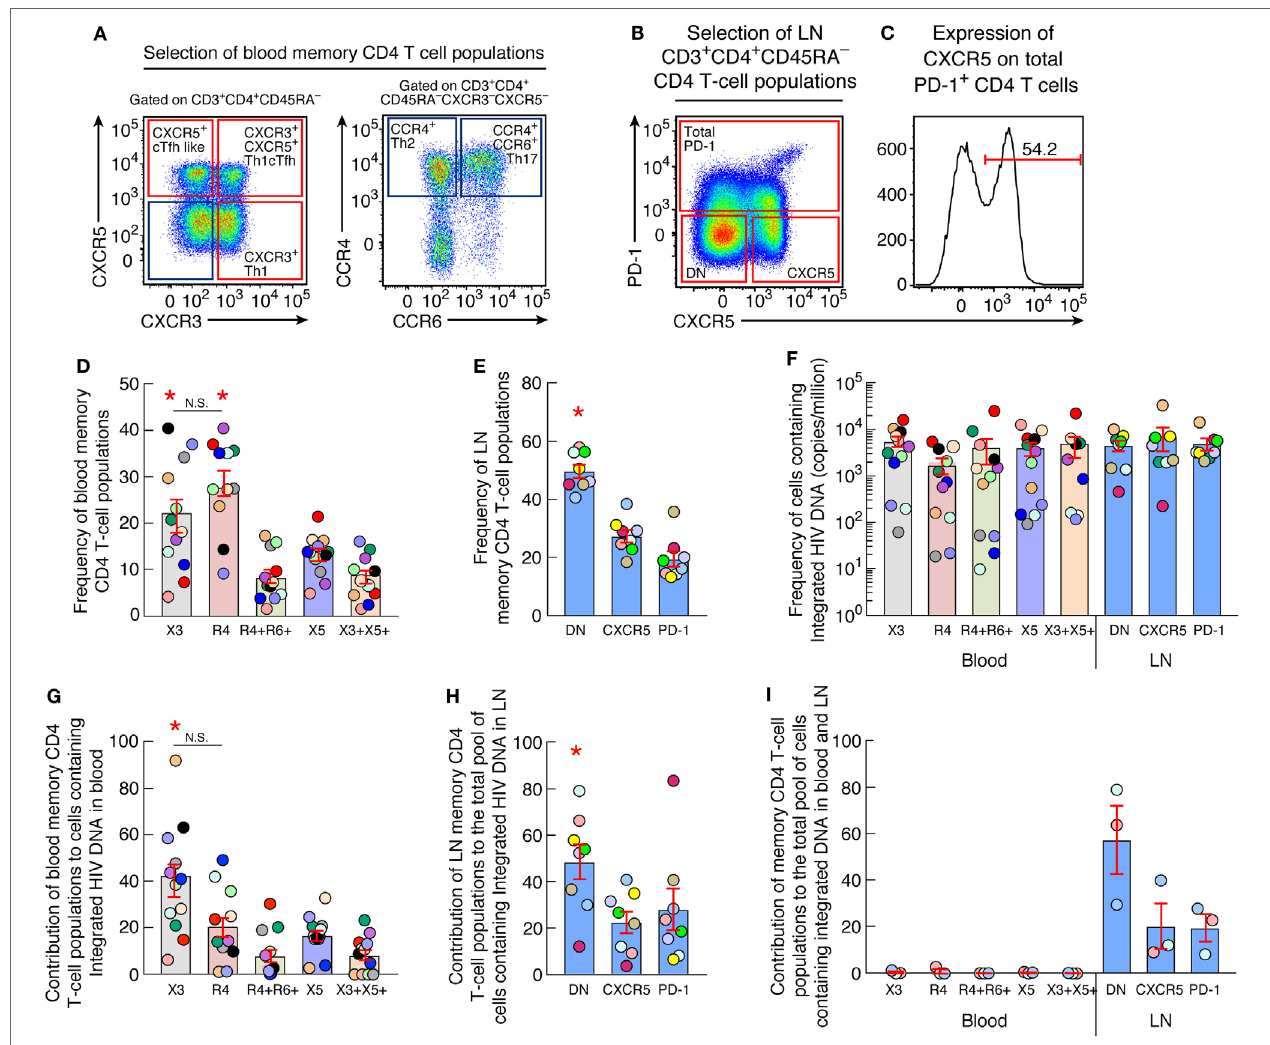
FigUre 1 | Quantification of HIV Integrated DNA in blood and lymph node memory CD4 T-cell populations (a) Representative flow cytometry profile of blood memory (CD45RA − ) CD4 T-cell populations expressing chemokine receptors isolated from one representative aviremic long-term-treated HIV-1-infected individual. (B) Representative flow cytometry profile of lymph nodes (LN) memory (CD45RA − ) CD4 T-cell populations expressing CXCR5 and/or PD-1 isolated from one aviremic HIV-1-infected long term-treated subject. (c) Representative flow cytometry profile of surface expression of CXCR5 on LN PD-1 + memory CD4 T cells isolated from one representative aviremic long-term-treated HIV-1-infected individual. (D) Frequency of chemokine receptor expressing blood memory (CD45RA − ) CD4 T cells isolated from aviremic long-term-treated HIV-1-infected individuals ( N = 12). (e) Frequency of CXCR5 and/or PD-1-expressing LN CD4 T cells isolated from aviremic long-term-treated HIV-1-infected individual ( N = 8). (F) Frequency of cells containing integrated HIV DNA (copies per million cells) within chemokine receptor expressing blood ( N = 12) and CXCR5 and/or PD-1 expressing LN ( N = 8) memory CD4 T-cell populations. (g) Contribution of chemokine receptor expressing blood memory CD4 T-cell populations to the total pool of cells containing integrated HIV DNA in blood ( N = 12). (h) Contribution of CXCR5 and/or PD-1 expressing LN memory CD4 T-cell populations to the total pool of cells containing integrated HIV DNA in LN ( N = 8). (i) Contribution of blood and LN memory CD4 T-cell populations of matched individuals to the total body pool of cells containing integrated HIV DNA in blood and LN compartments ( N = 3). HIV-infected individuals are color coded (D–i) . Histograms correspond to mean of blood or lymph node CD4 T-cell population (D–i) ; red bars correspond to SEM (D–i) . “X3” corresponds to blood CXCR3-expressing CD4 T cells; “R4” corresponds to blood CCR4-expressing CD4 T cells; R4 + R6 + corresponds to blood CCR4 + CCR6 + CD4 T cells; “X5” corresponds to blood CXCR5-expressing CD4 T cells; And X3 + X5 + corresponds to blood CXCR3 + CXCR5 + CD4 T cells. “LN” corresponds to lymph node. Red stars indicate statistical significance ( P < 0.05). Statistical significance ( P -values) was obtained using one-way ANOVA (Kruskal–Wallis test) followed by Wilcoxon matched-pairs two-tailed signed rank test (D–i)